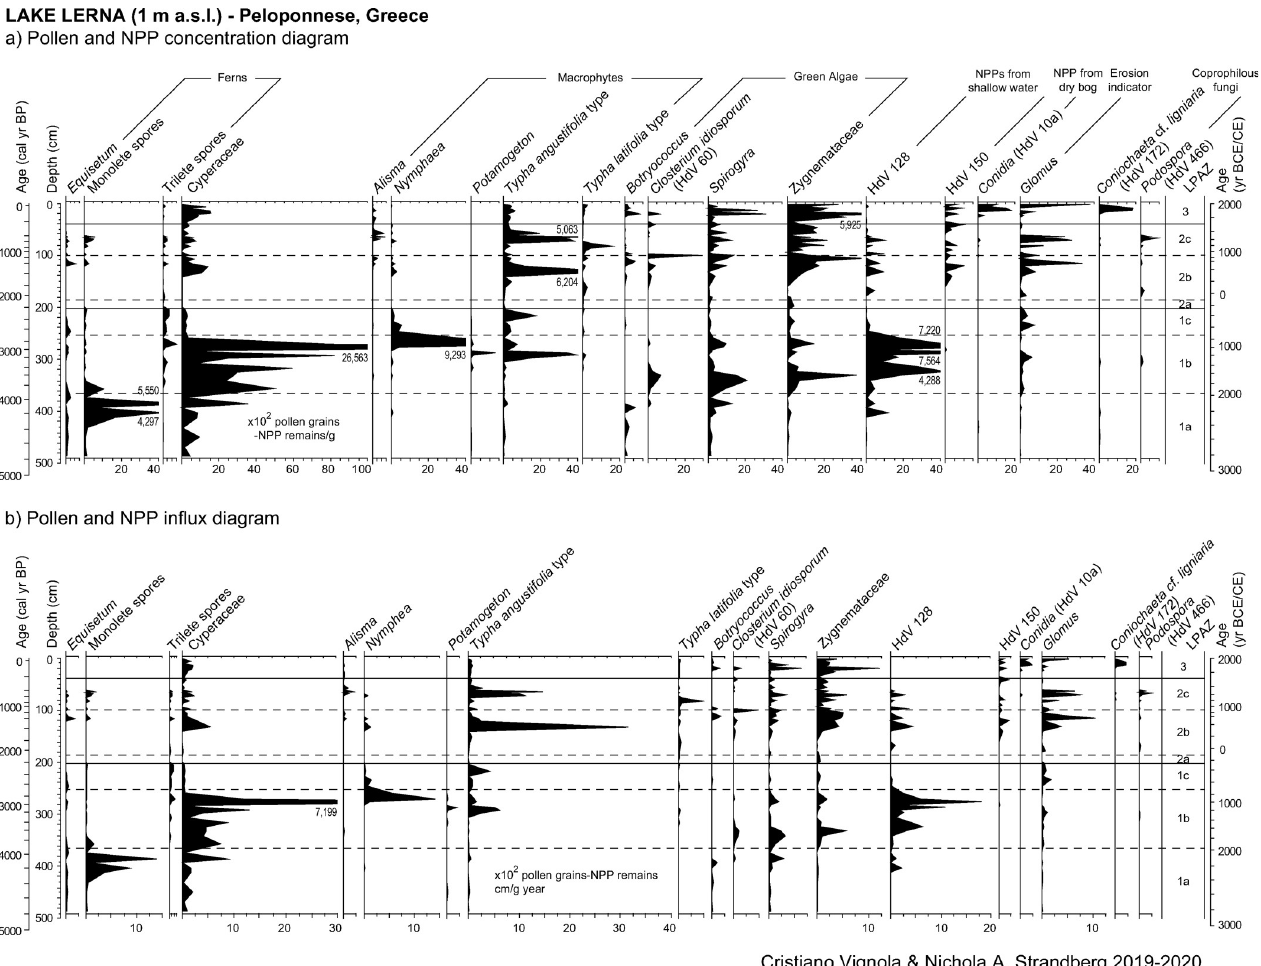
Fig 6. Results of pollen analysis of the study core from ancient Lake Lerna (Peloponnese, Greece). (a) Pollen concentration and (b) influx diagrams of selected aquatic and NPP taxa and charcoals.